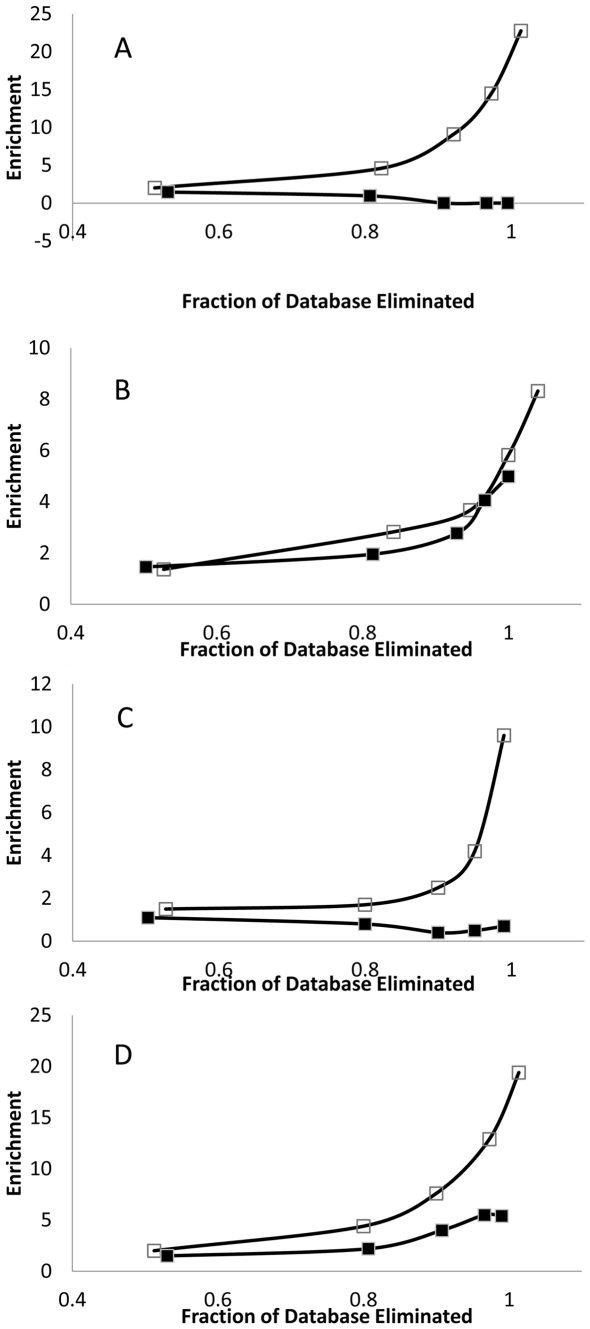
Enrichment curves.The ability of analysis by the internal consensus approach and Vina to promote ligand enrichment over decoys in virtual screening is shown. Enrichment is presented as a function of the fraction of the original database eliminated in the screen. Protein targets: A. Thymidine kinase; B. Estrogen receptor; C. Neuraminidase; D. S-adenosyl homocysteine hydrolase. An enrichment factor of 1.0 corresponds to a random selection of genuine ligands from decoys. Closed markers, Vina; open markers, internal consensus.